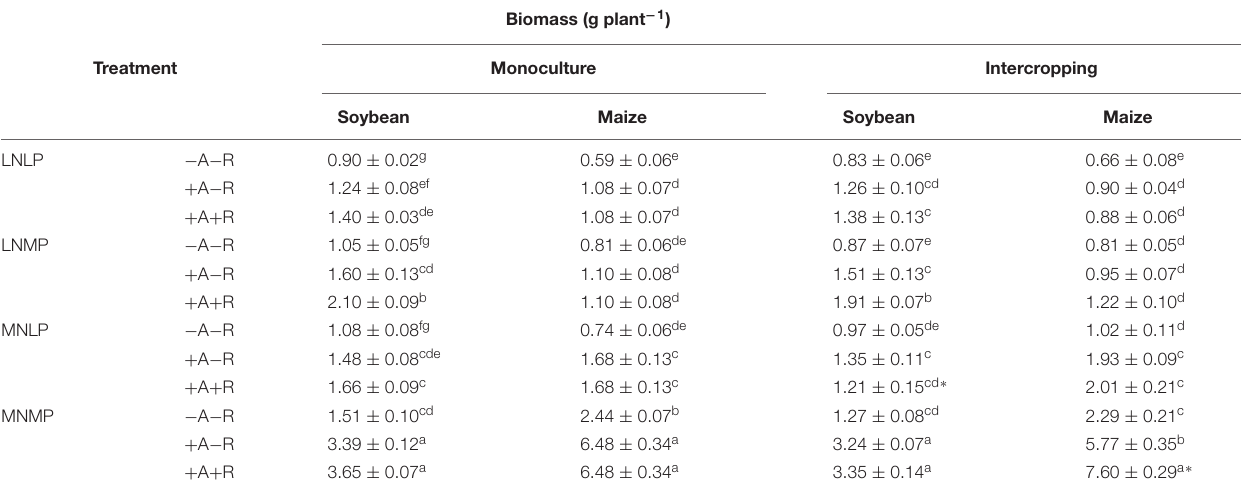
TABLE 1 | Biomasses of soybean and maize inoculated with AMF and rhizobia under different N and P conditions in a greenhouse